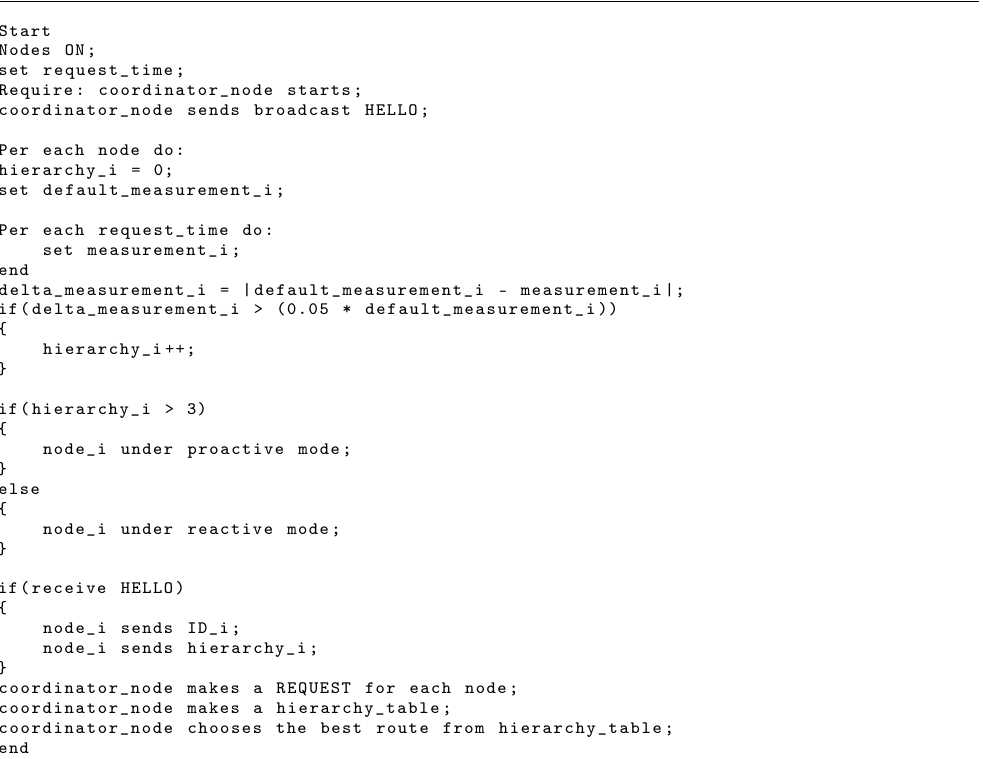
Algorithm 2 Cooperative algorithm